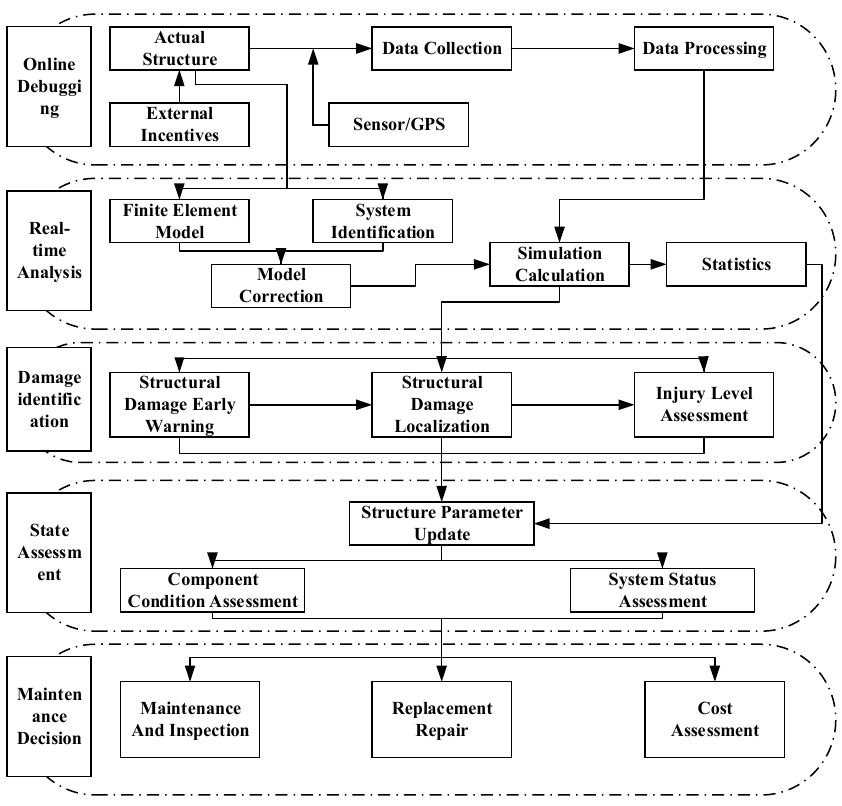
Figure 6. Schematic diagram of structural state assessment and safety prognosis system.